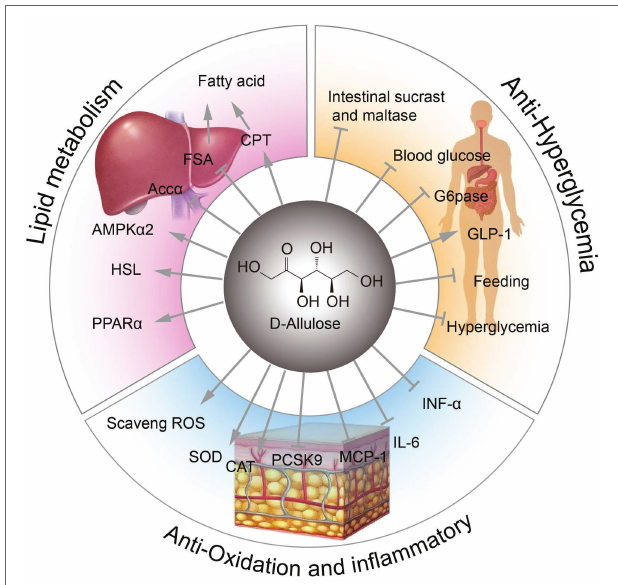
FIGURE 1 | The physiological functions of D-allulose. FSA, fatty acid synthase; CPT, carnitine palmitoyltransferase; ACC α , acetyl-CoA carboxylase alpha; AMPK α , AMP-activated protein kinase alpha; HSL, hormone-sensitive lipase; PPAR α , peroxisome proliferator activated receptor alpha; ROS, reactive oxygen species; SOD, superoxide dismutase; CAT, catalase activity; Pcsk9, proprotein convertase subtilisin/kexin type 9; MCP-1, monocyte chemoattractant protein 1; G6Pase,